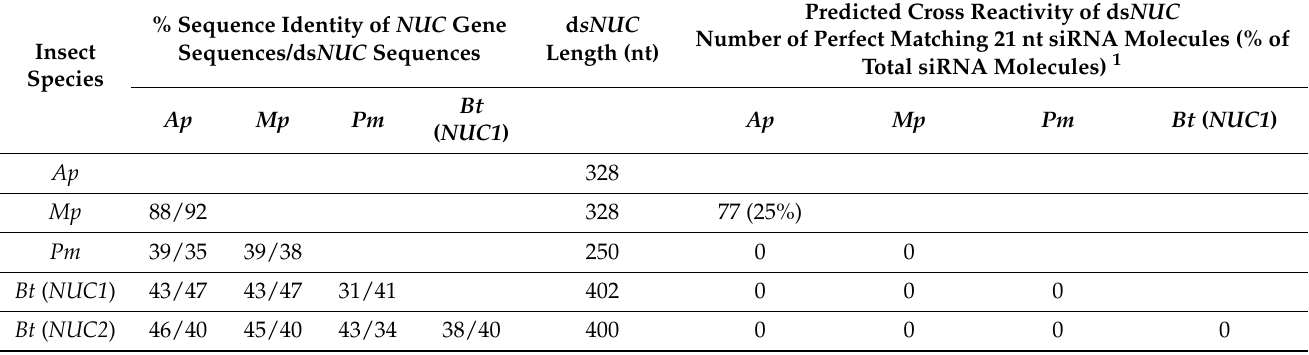
Predicted Cross Reactivity of ds NUC d sNUC Number of Perfect Matching 21 nt siRNA Molecules (% of Length (nt) Total siRNA Molecules)